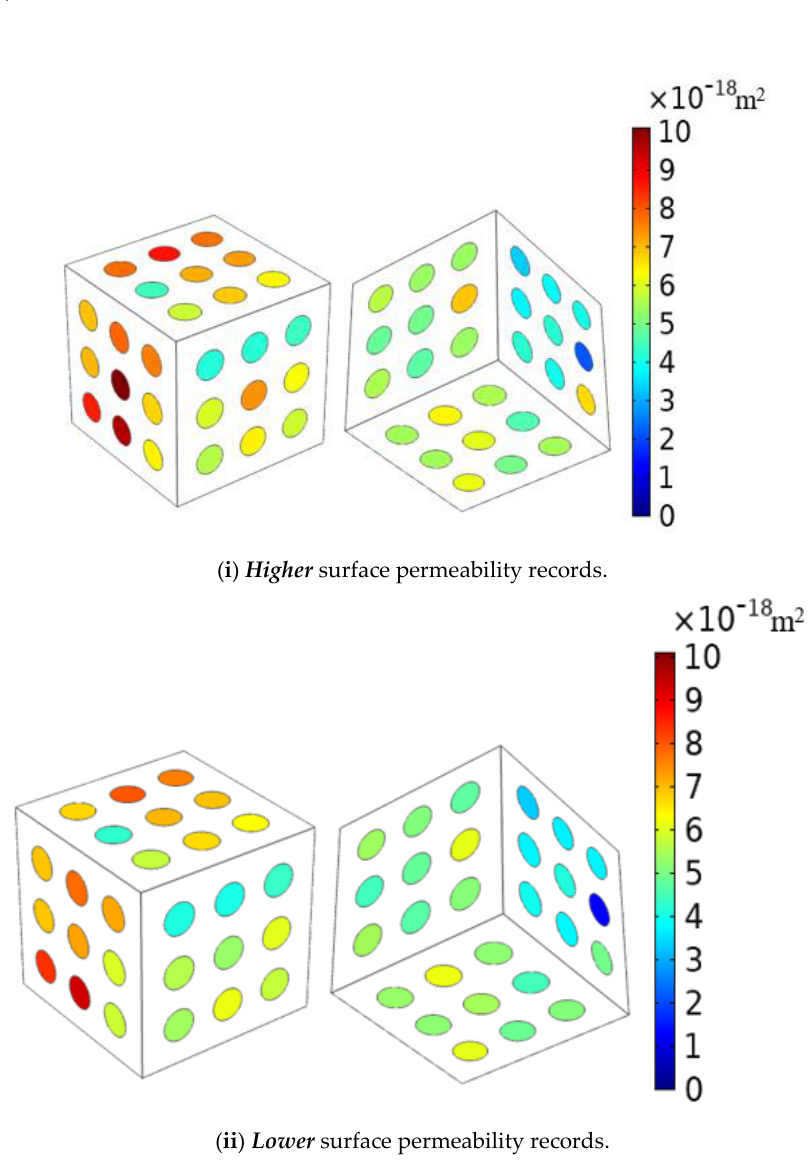
Figure 8. Surface permeability data for the Stanstead granite.